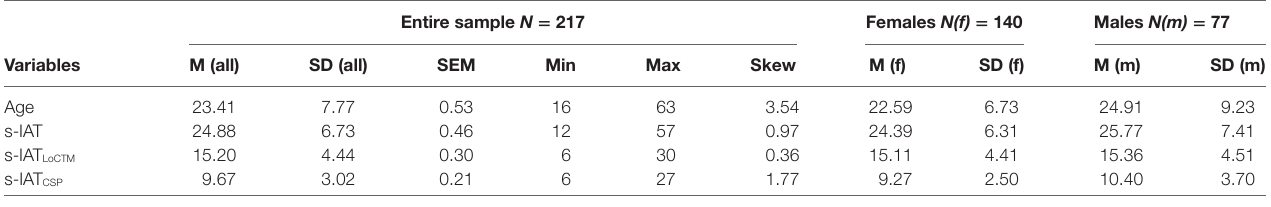
Table 1 | Descriptive statistics of age and Internet variable data for the entire sample and split by gender.